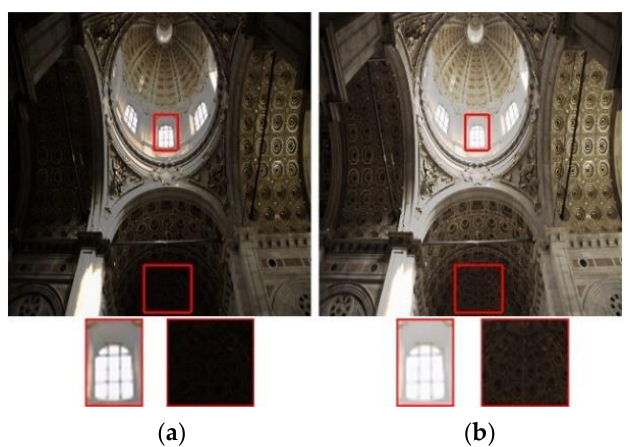
Figure 8. Enhanced results of the raw image shown in Figure 7a. ( a ) Image enhanced by Equation (12); ( b ) image enhanced by Equation (13).